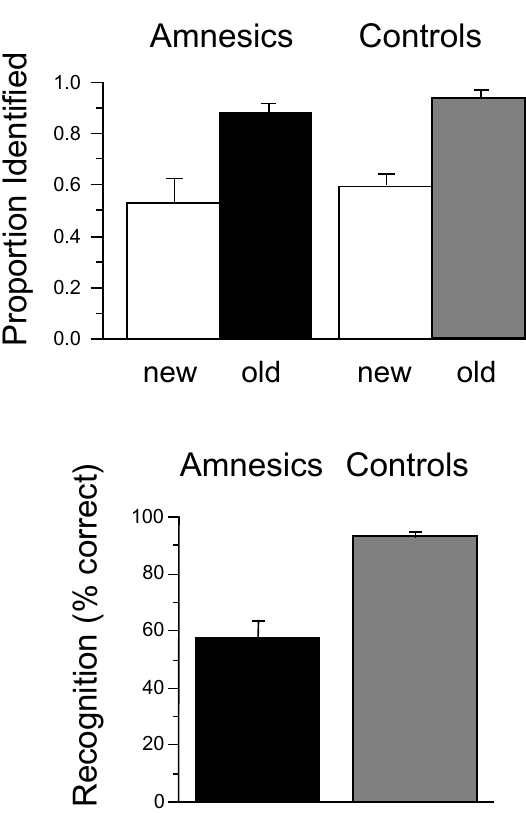
Fig. 1. Memory performance in amnesic patients and age-matched control subjects on implicit and explicit memory tests. Patients with amnesia exhibited normal word-identification priming (top) and im- paired 3-alternative recognition for the same words (bottom). Figure adapted from